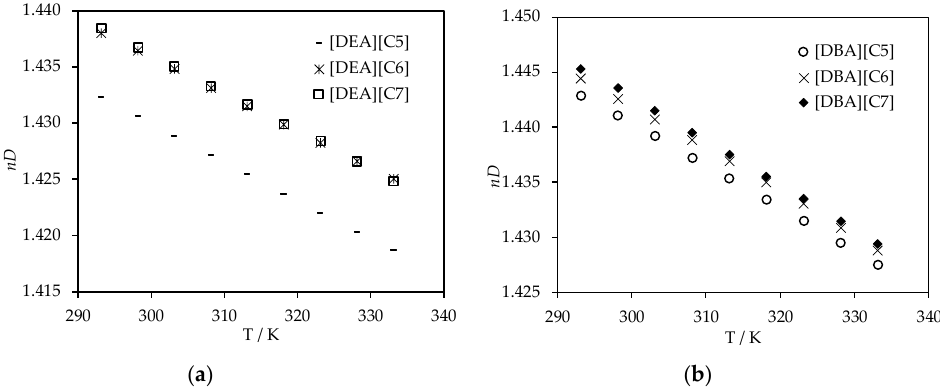
Figure 3. ( a ) Refractive index ( n D ) values of [DEA][C5], [DEA][C6] and [DEA][C7] as a function of temperature. ( b ) Refractive index ( n D ) values of [DBA][C5], [DBA][C6] and [DBA][C7] as a function of temperature.